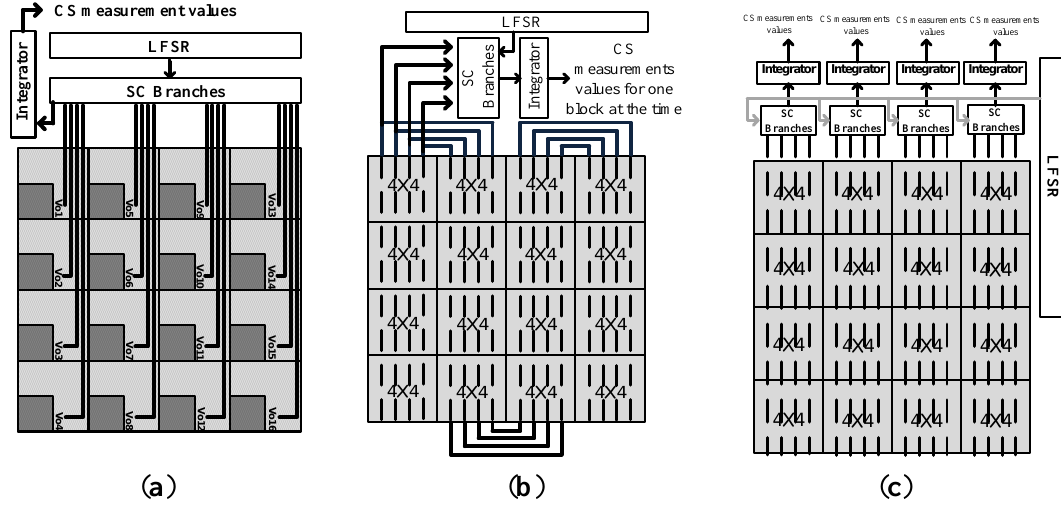
Figure 7. ( a ) Connections of each block toward the linear feedback shift register (LFSR); ( b ) Block connections for block-by-block read-out; ( c ) Block connections for column-of-blocks connections (adapted from [63]).